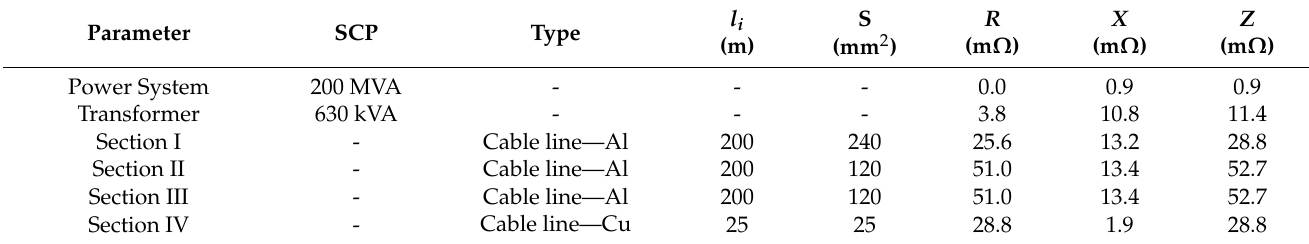
Table 2. Parameters of selected low-voltage power grid configurations with radial topology—Line 2.